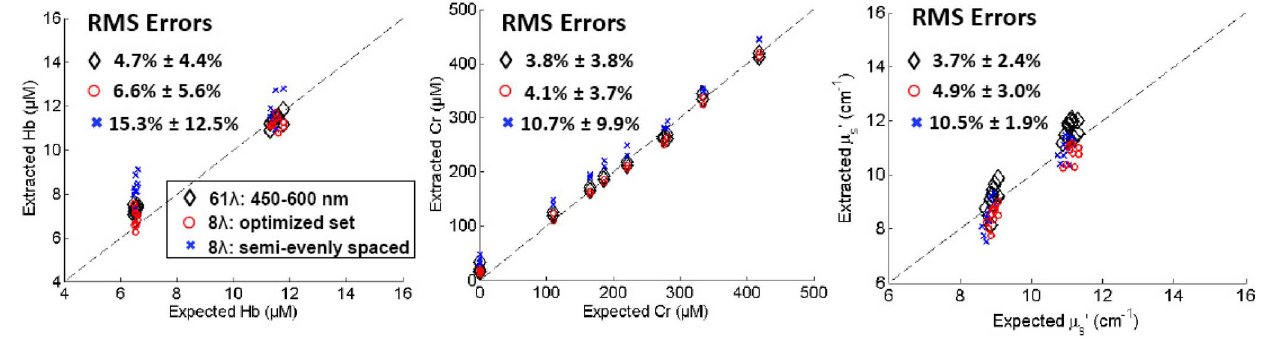
Figure 9. Multi-absorber phantom optical properties extracted with and without optimization. Comparison of extraction accuracy for [Hb], [Cr], and , m s ’ . using the full 450–600 nm spectrum, the optimized wavelength solution, and the evenly spaced wavelengths selected empirically for a previously reported system.